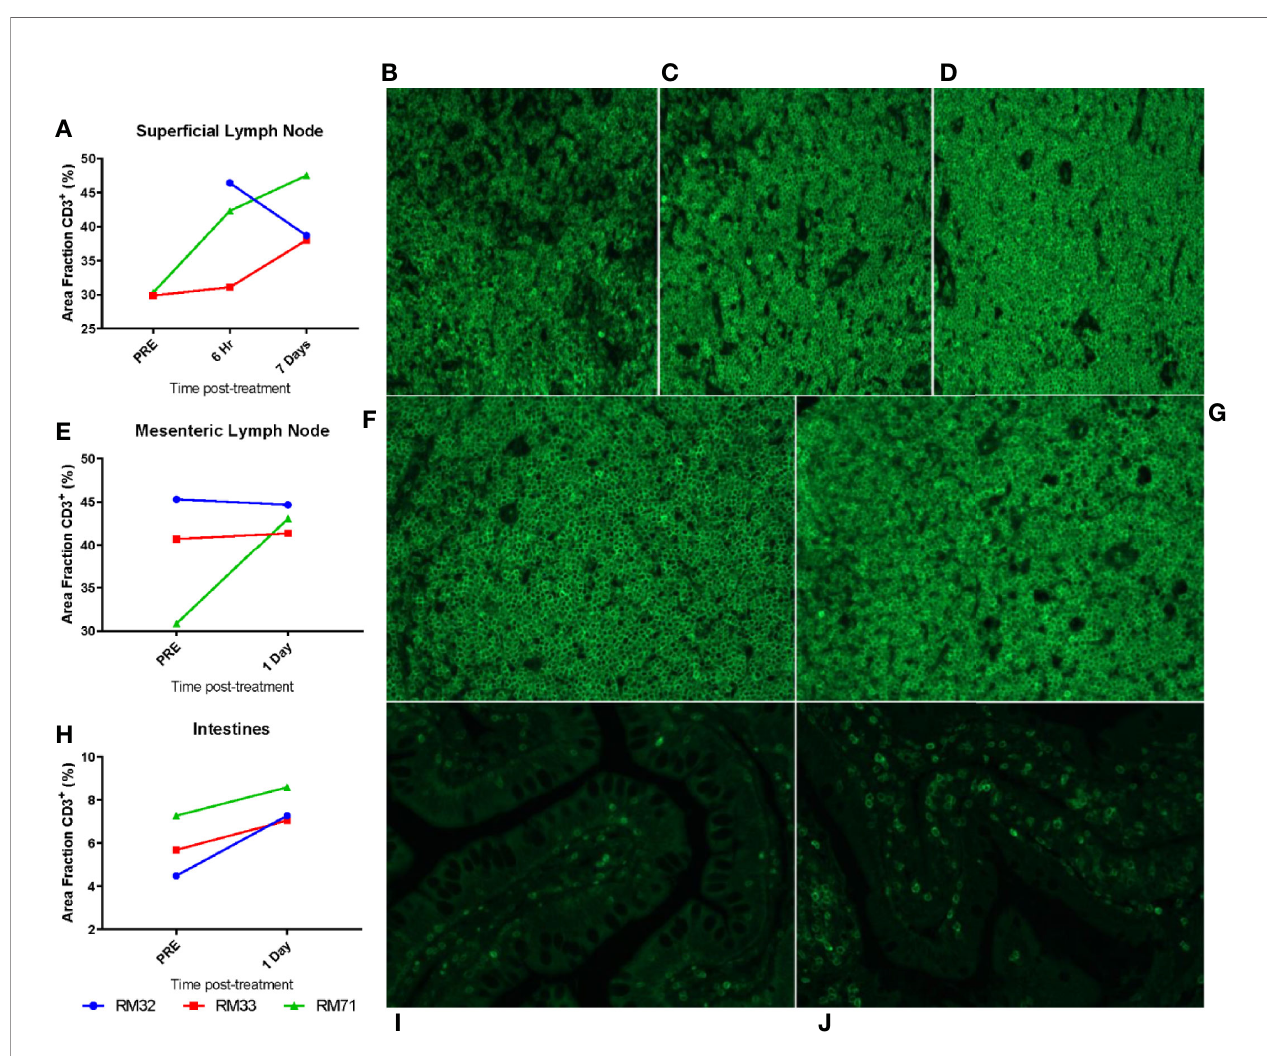
FIGURE 10 | Migration of CD3 + T cells to tissues from the periphery. Super fi cial LNs (A – D) , mesenteric LNs (E – G) , and intestinal resections (H – J) were embedded in paraf fi n and subsequently stained for CD3. Threshold quanti fi cation of total positive area for CD3 fl uorescence for super fi cial LNs (A) , mesenteric LNs (E) , and intestinal resections (H) . Representative images from super fi cial LNs are shown at pre (B , 6 hpi (C) , and 7 dpi (D) ; mesenteric LNs at pre (F) , 1 dpi (G) ; intestinal resections at pre (I) and 1 dpi (J)